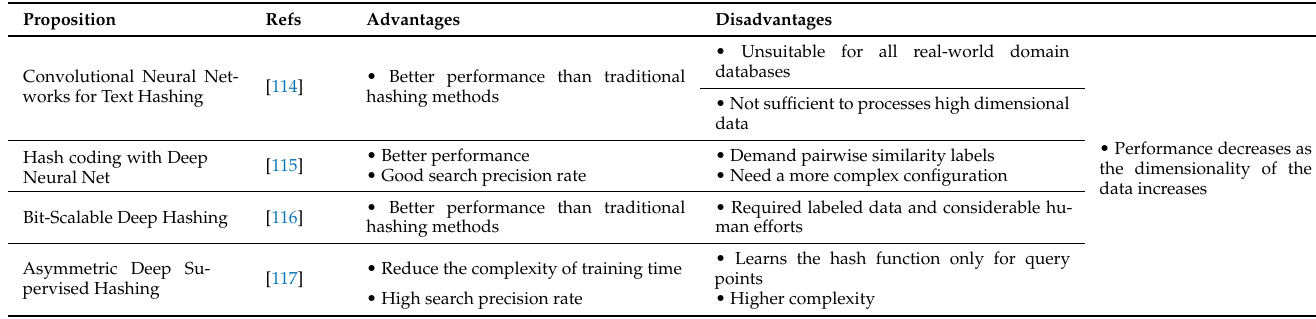
Table 6. Summary of advantage and disadvantage of deep hashing